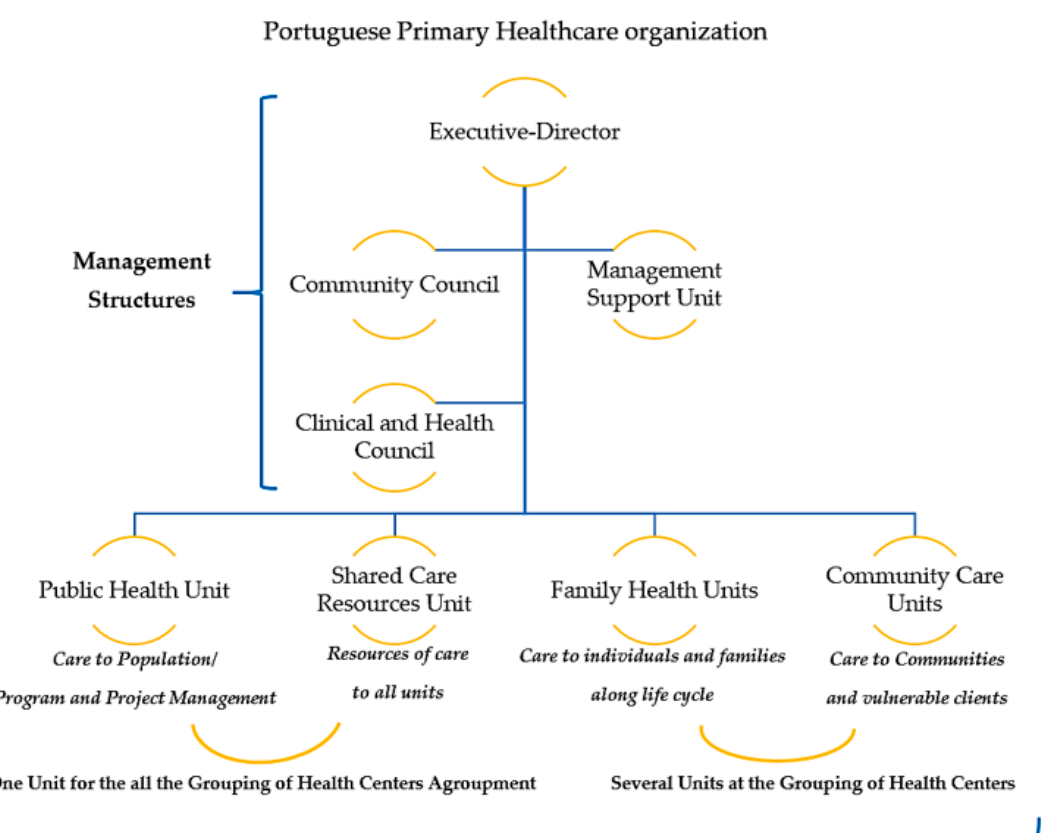
Figure 1. Portuguese primary healthcare organization.